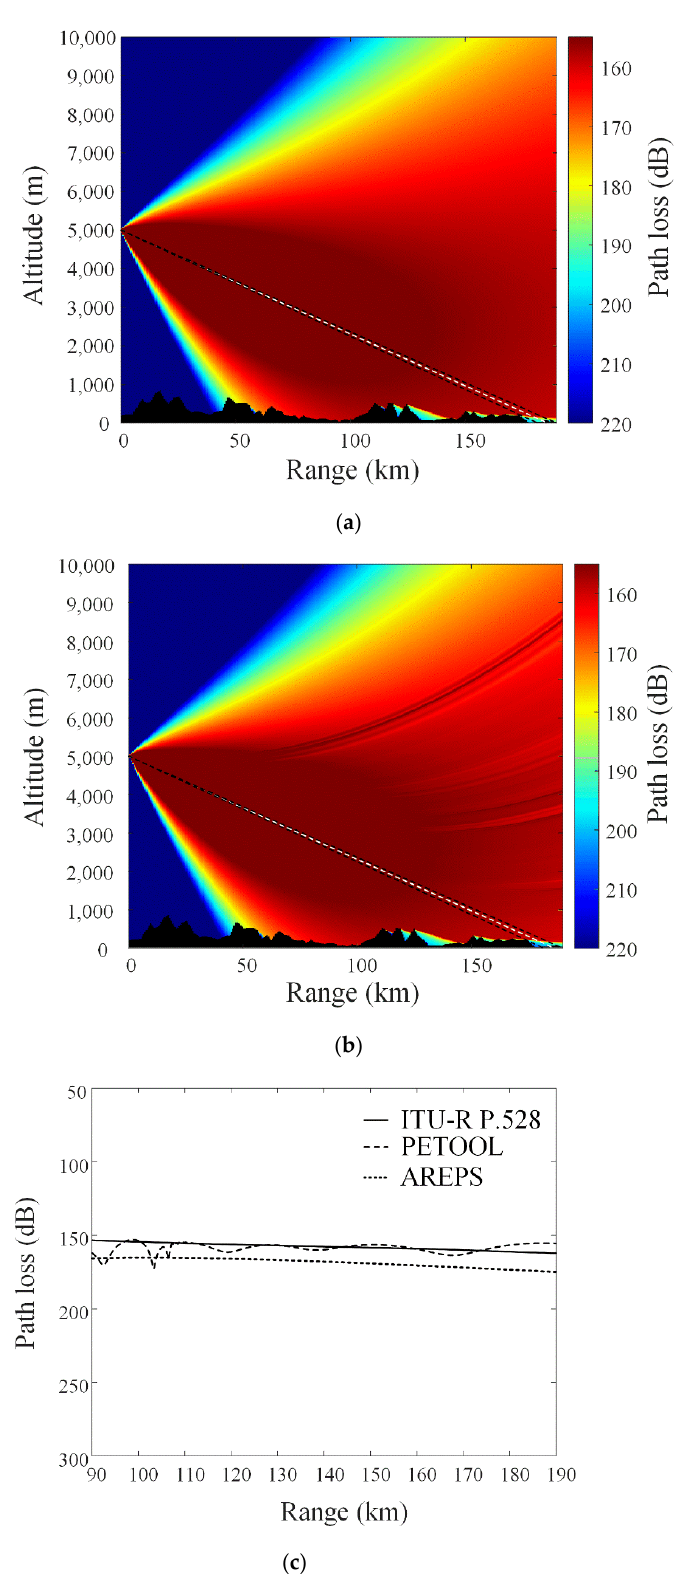
Figure 6. Path loss simulation results between Pohang (S 4 ) and Heuksando (S 6 ) as a function of the range and altitude: ( a ) the standard atmospheric conditions; ( b ) the observation-based atmospheric condition on 15 February 2019; and ( c ) the path loss comparison among the simulation tools.